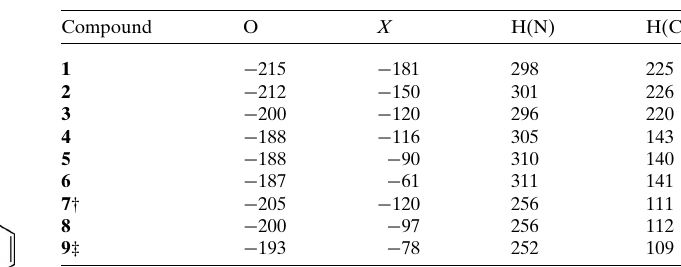
ð 8 Þ synthon 2